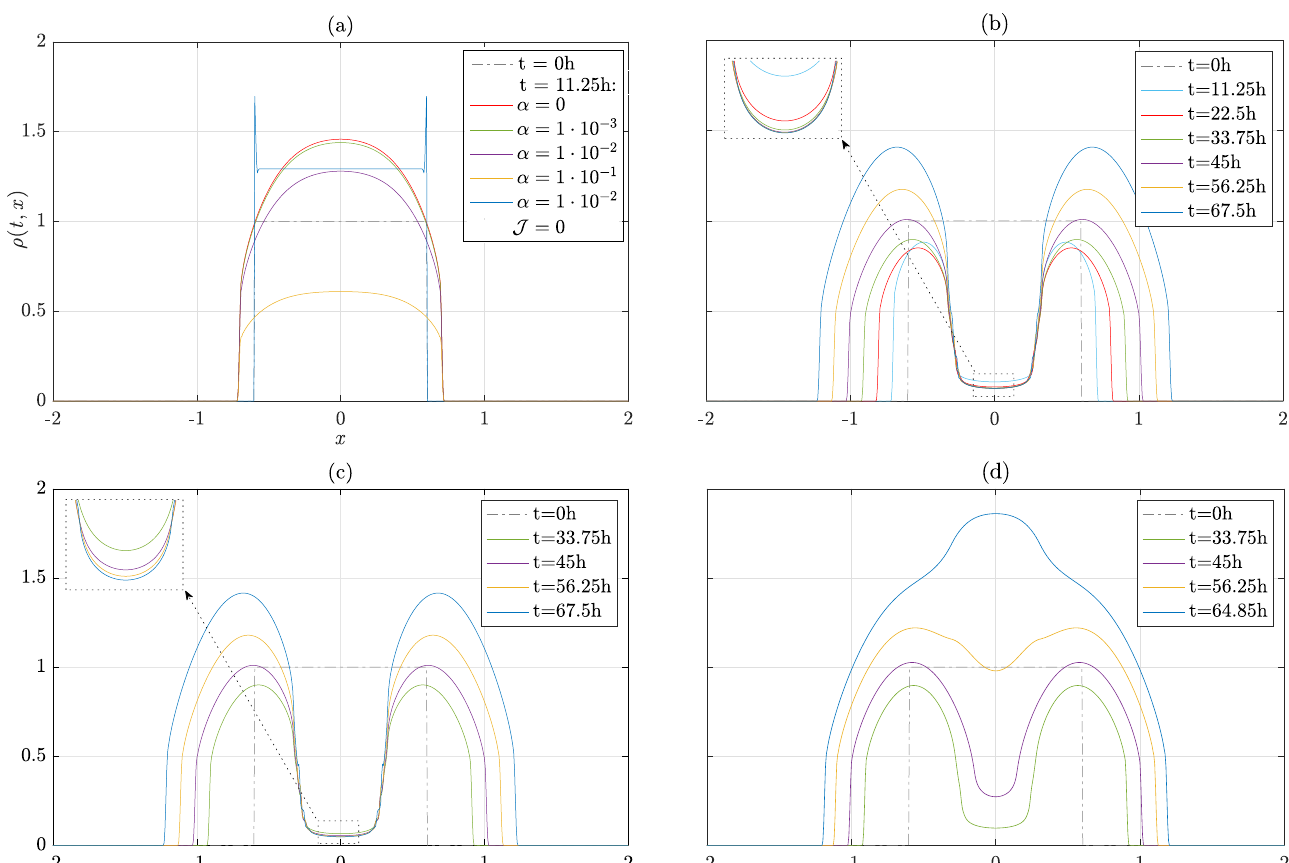
Figure 4. Migration, growth and pressure interactions. ( a ) Effect of constant α parameter on growth and migration at time t = 11.25 h with β = 3.45 · 10 − 2 h − 1 . ( b ) Cluster of cells with high pressure in the core than its surroundings ( α = 1 mm 2 cell − 1 h − 1 and α = 1 · 10 − 3 mm 2 cell − 1 h − 1 respectively). Proliferation rate is assumed constant β = 3.45 · 10 − 2 h − 1 . ( c ) Heterogeneous proliferation rate is considered in space (same α parameters than in Figure 4b) and in time. At t = 30 h, β = 3.45 · 10 − 3 h − 1 and at t = 50 h proliferation is considered totally inhibited, β = 0 h − 1 . In the inner regions, β = 3.45 · 10 − 2 h − 1 . ( d ) Pressure is lifted at time t = 30 h, where α = 1 · 10 − 3 mm 2 cell − 1 h − 1 and β = 3.45 · 10 − 2 h − 1 . At t = 50 h, tendency of α and β changes: α = 1 · 10 − 3 mm 2 cell − 1 h − 1 , β = 6.9 · 10 − 2 h − 1 and α = 5 · 10 − 3 mm 2 cell − 1 h − 1 , β = 3.45 · 10 − 2 h − 1 for the core and inner region. For the four cases, c ρ = 0.87 · 10 − 2 mm h − 1 and m =